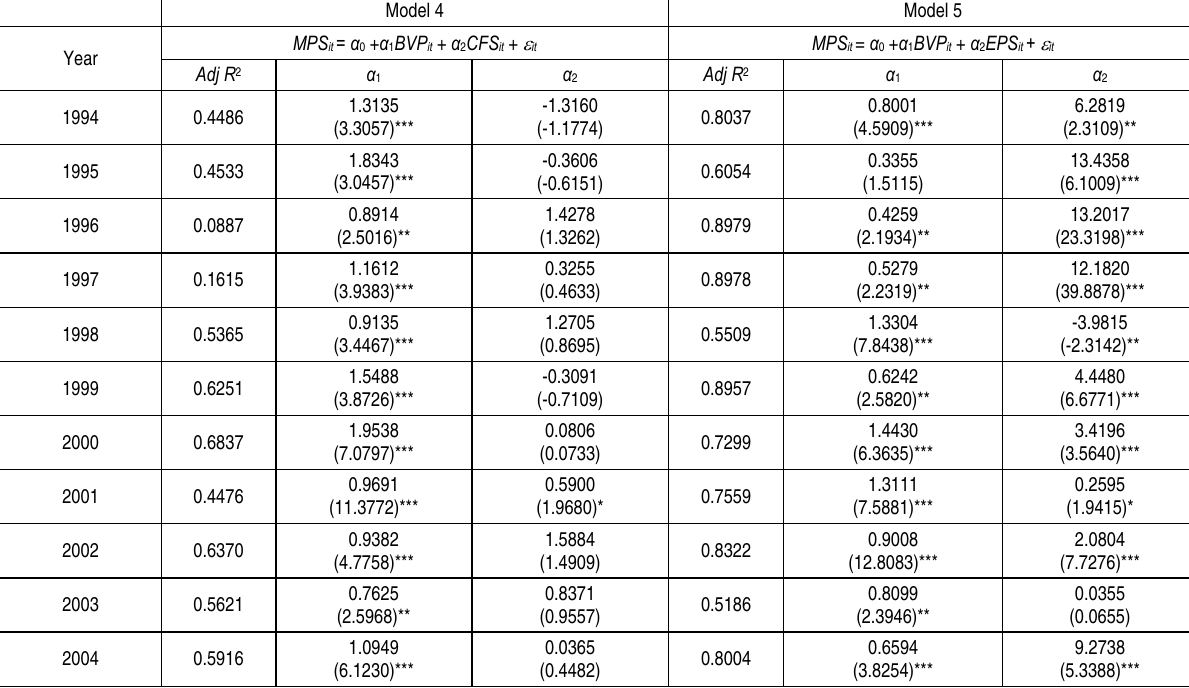
Table 5. Analyses of the value relevance of combined book value and earnings and combined book value and cash flow: multiple linear